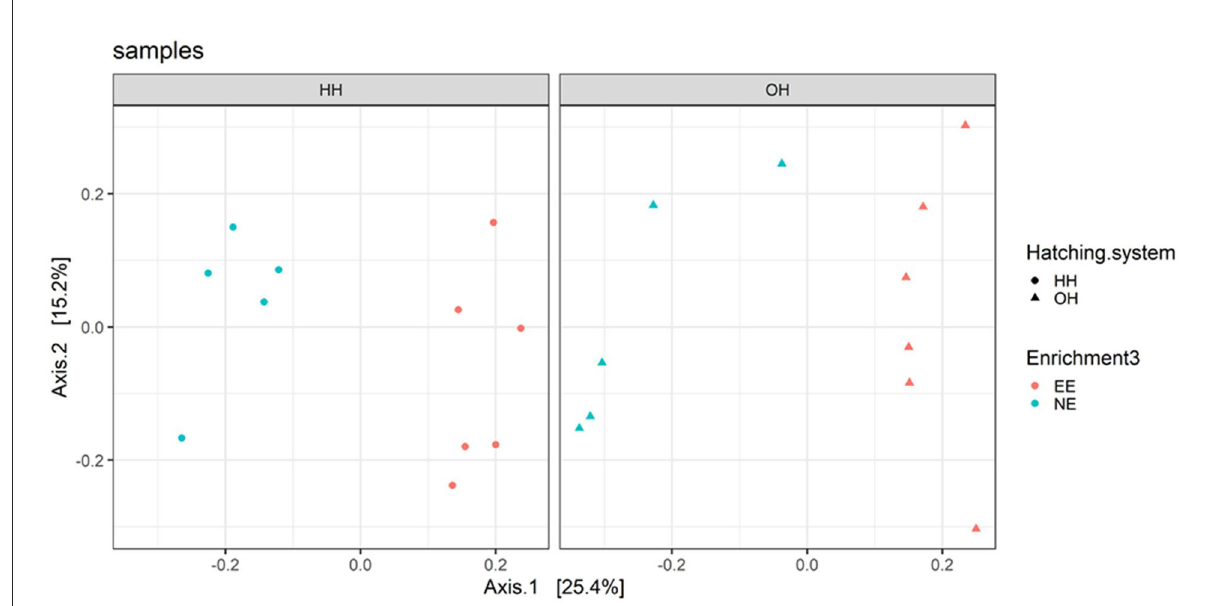
FIGURE3 Principal coordinate analysis (family level) of fecal microbiota on day 14 for pens with a dark brooder (EE) and without a brooder (NE) within the hatchery-hatched (HH) respectively, on-farm hatched treatments (OH). Each point represents a pen (pooled sample of six chickens per pen). For significant treatment differences, see text.